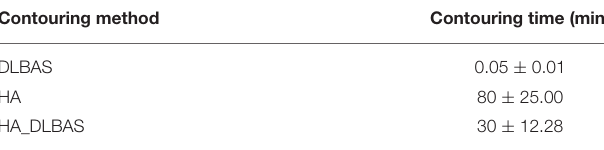
TABLE 7 | Comparison of contouring